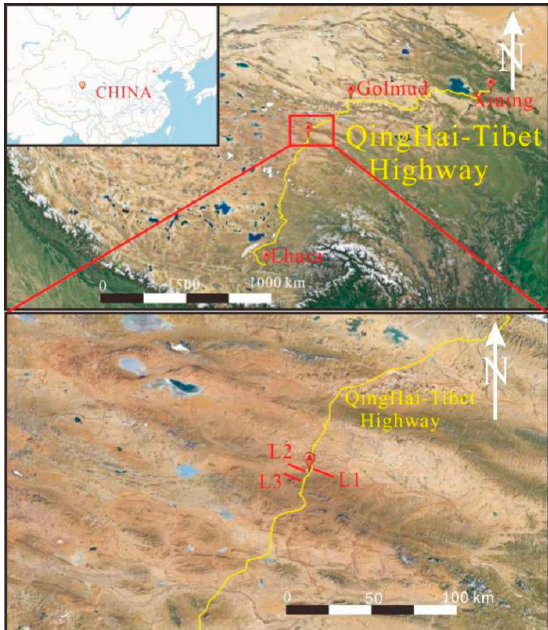
Figure 4. The location and lines layout diagram in Beiluhe permafrost region. Lines distribution on both sides of the Tibetan highway. We chose part of the section of on the east side of L1 line (the L1 red line) and on the west side of L3 line (the L3 red line) and L2 line (the L2 red line) to image RTM.